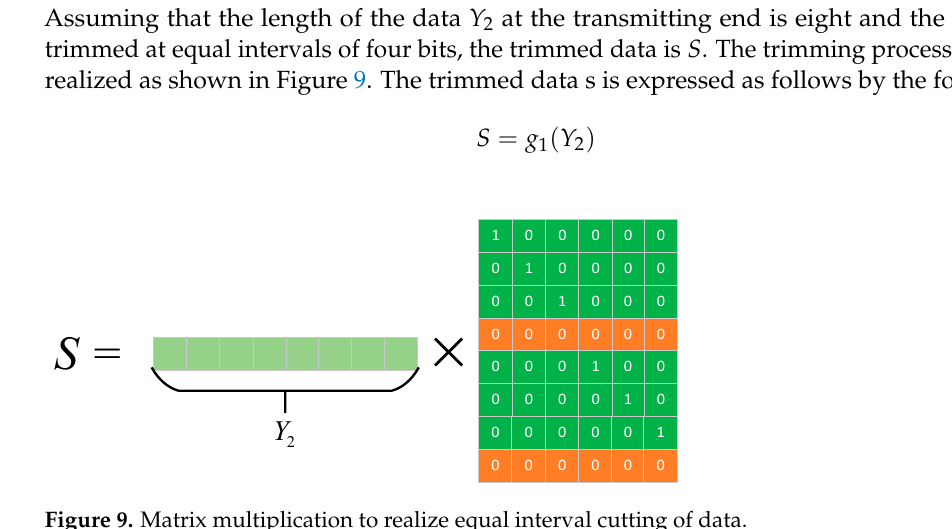
Figure 10. Data cutting method at the transmitting end.